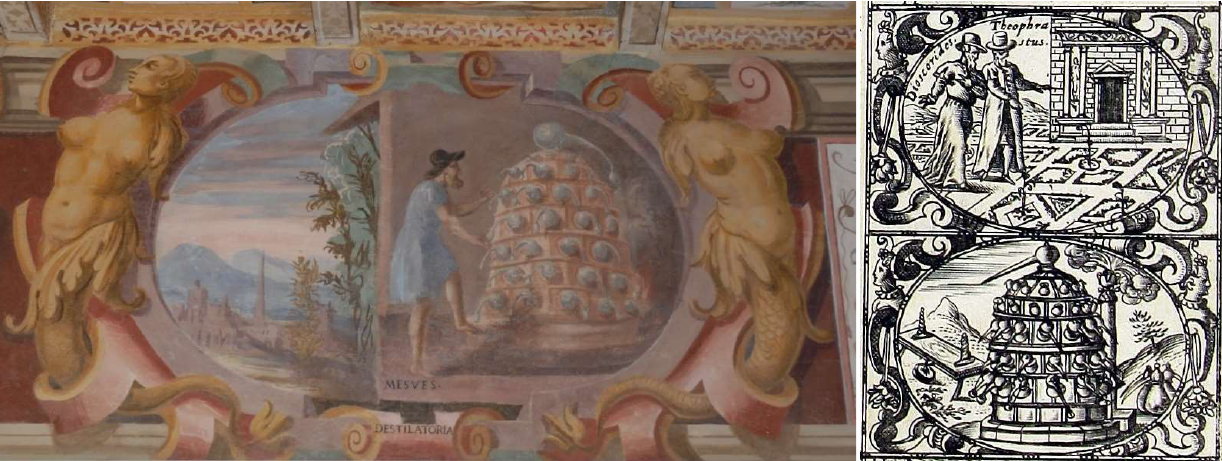
Figure 6. Left : The oval painting represents the “distillery,” where Mesue is the protagonist of the scene. Right : The distillery in the frontispiece of Giunti’s edition.